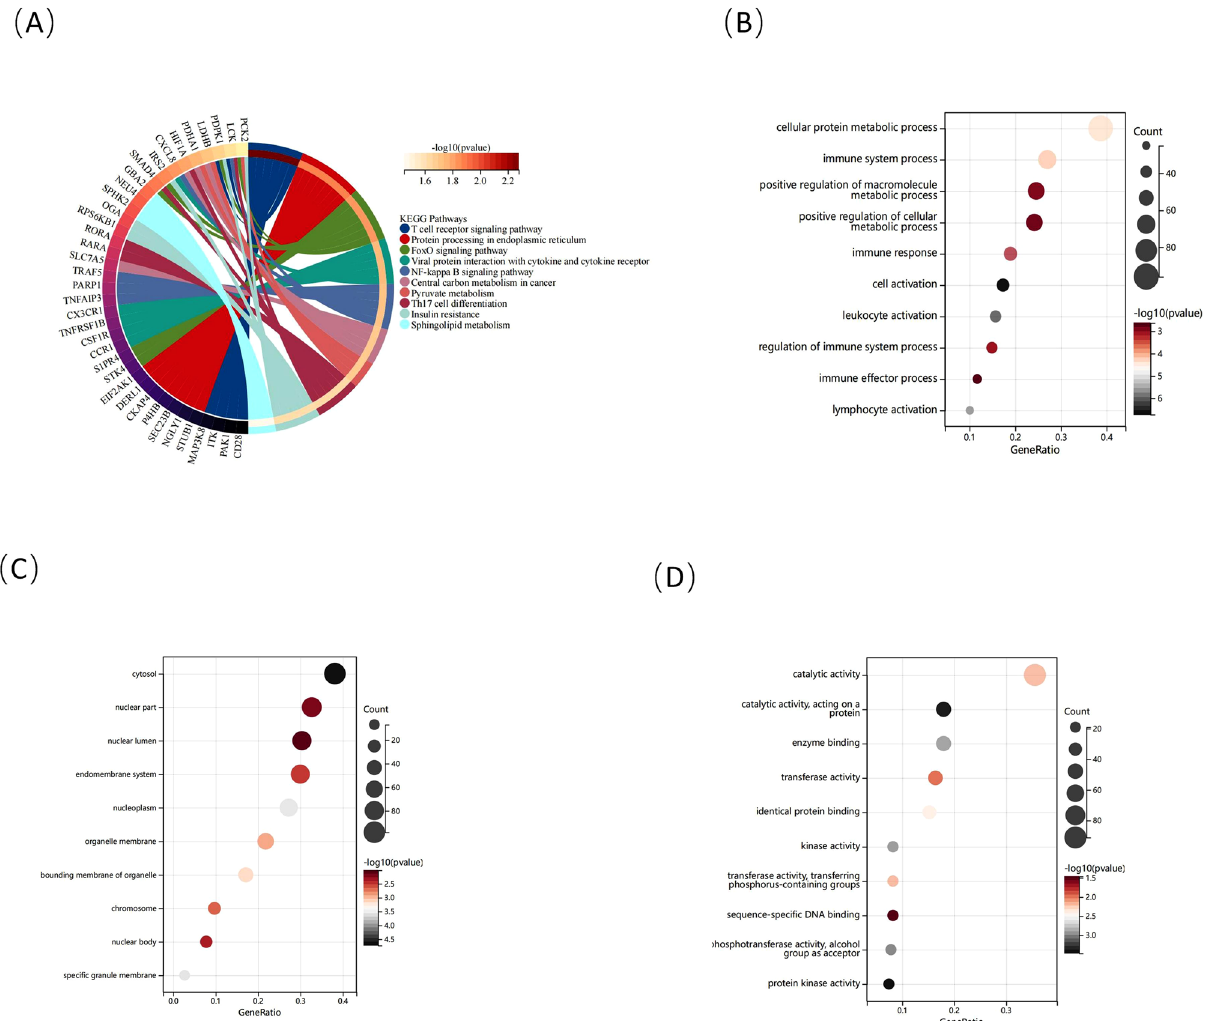
Figure 5. Enrichment analysis of candidate genes. ( A ) KEGG pathway analysis is shown in a circle diagram, with different colors representing different pathways. ( B–D ) Go analysis of candidate genes, including biological processes, cellular components, and molecular functions. Colored by P values, the X axis represents the proportion of enriched genes and the Y axis represents different